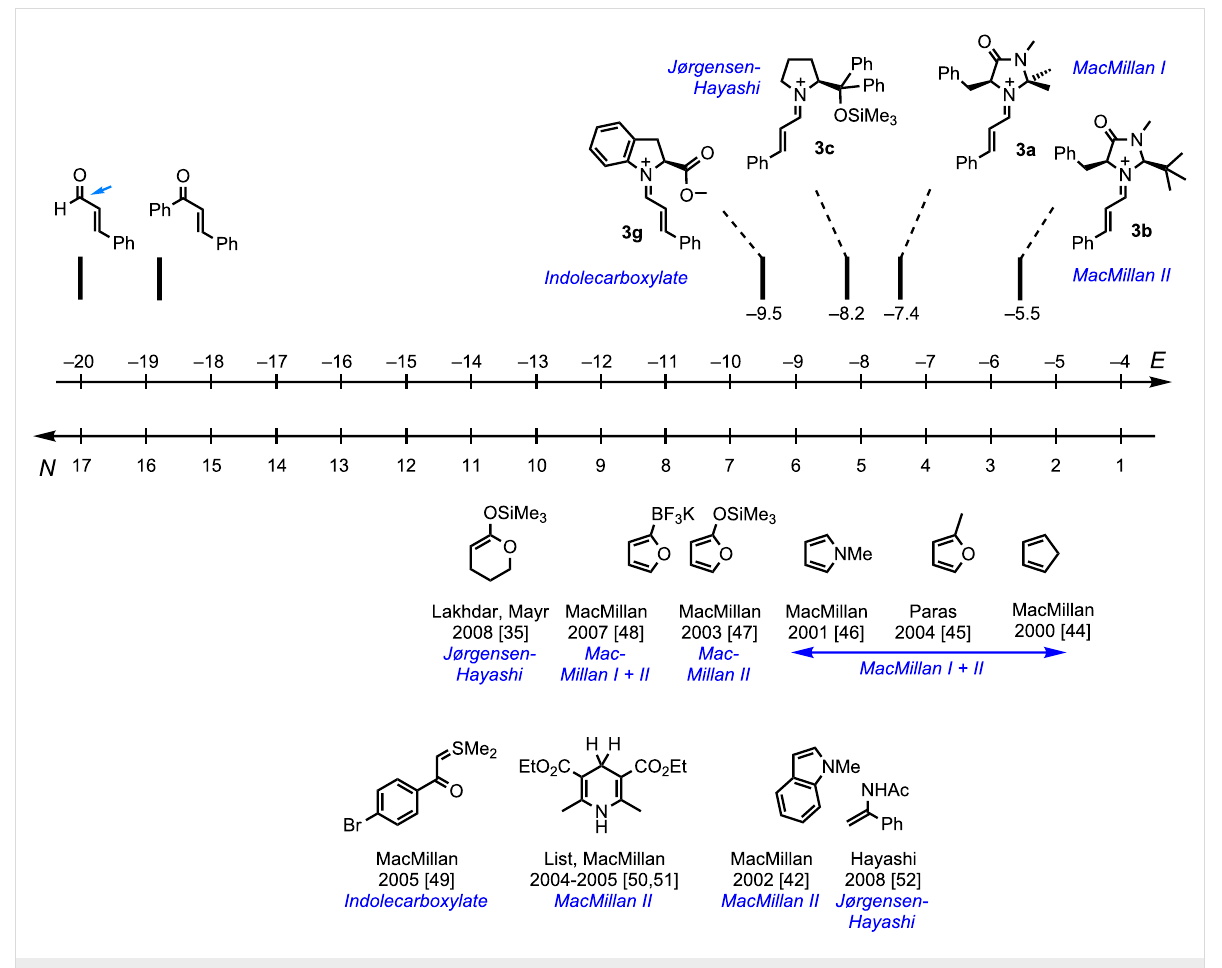
Figure 7: Nucleophiles used in iminium activated reactions [35,42,44-52].